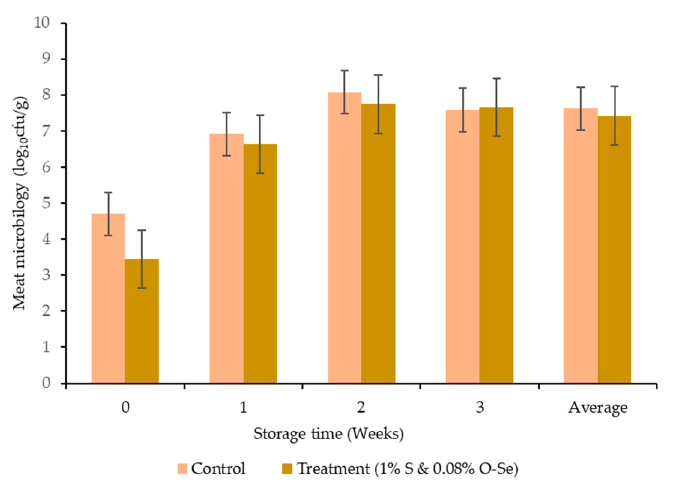
Figure 3. Effect of stevioside and organic selenium on the microbial content in meats of Hanwoo cattle. Although no significant impact ( p > 0.05) was observed for color, flavor, tenderness, juiciness, and palatability, the S- and O-Se-supplemented diet had a positive tendency on the sensory parameters (Figure 4).